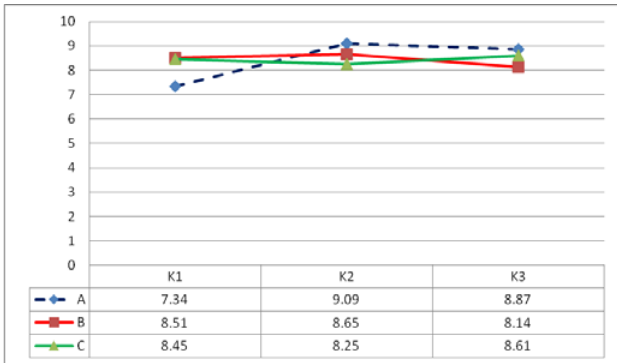
Figure 6: Relationship between the factors, the levels, and the K values (steel fiber).